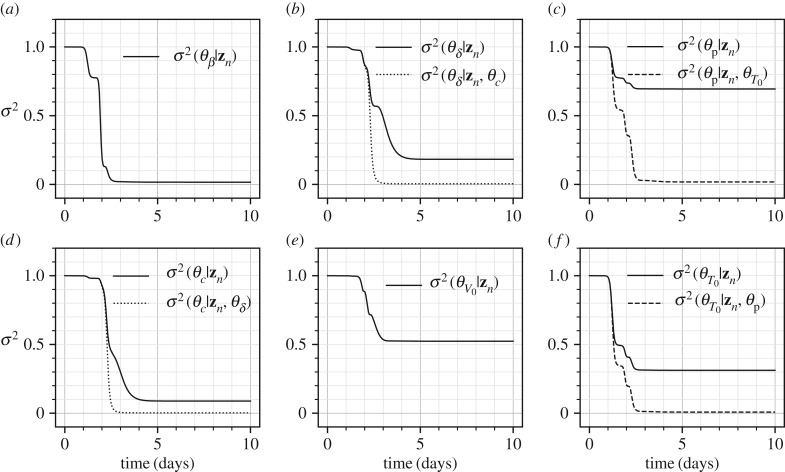
Marginal posterior variances (solid lines) and conditional variances (dashed lines) for the parameters of the influenza A kinetics model. Only V is measured with a measurement noise of σ2noise = 2.5 × 107 (TCID50 ml−1)2.